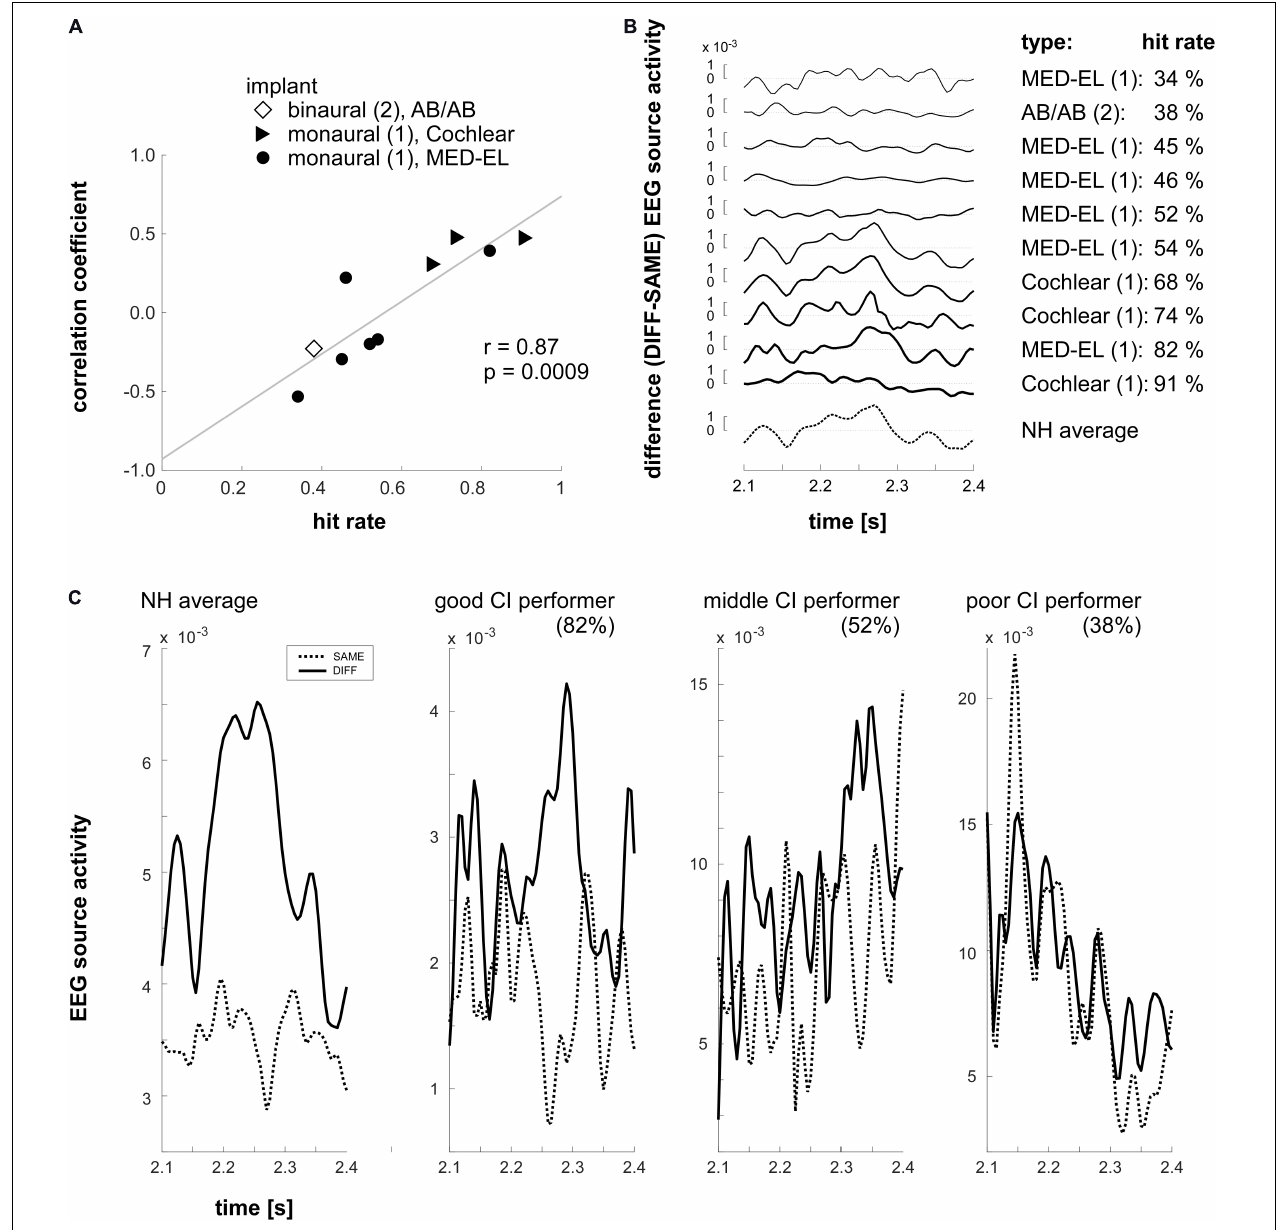
FIGURE 6 | (A) Correlation (Pearson, two-tailed) between sound localization performance and the correlation coefficients (Pearson, two-tailed) capturing the similarity of the COI activations between individual CI users and the group of normal hearing individuals. Bilateral and unilateral implantations as well as CI-types are indicated by different symbols: diamond: binaural, AB/AB; triangle: monaural, Cochlear; circle: monaural, MED-EL. For the correlation analysis the COI activation in the time window ranging from 2100 to 2400 ms was considered. A highly significant correlation was found in the right TPO (C2). It indicates that the more similar the individual CI users’ source activity with the activation observed in the normal hearing subjects in the right TPO region, the better sound localization performance had the CI user in the MMRS task. (B) Individual differential (DIFF – SAME) EEG source activity of the CI users in the right TPO (C2) region. The depicted source activity is the activity shared with the average source activity of the normal hearing group (NH average; please refer to the main text for further details). Furthermore, hit rates and correlation coefficients of the differential source activity between individual CI users and the mean of the normal hearing group in the 2100–2400 ms time window are shown. (C) SAME and DIFF source time courses of the average of the normal hearing (NH) group and three representative CI users with good, middle, and poor sound localization performance (the individual task hit rate is indicated in the